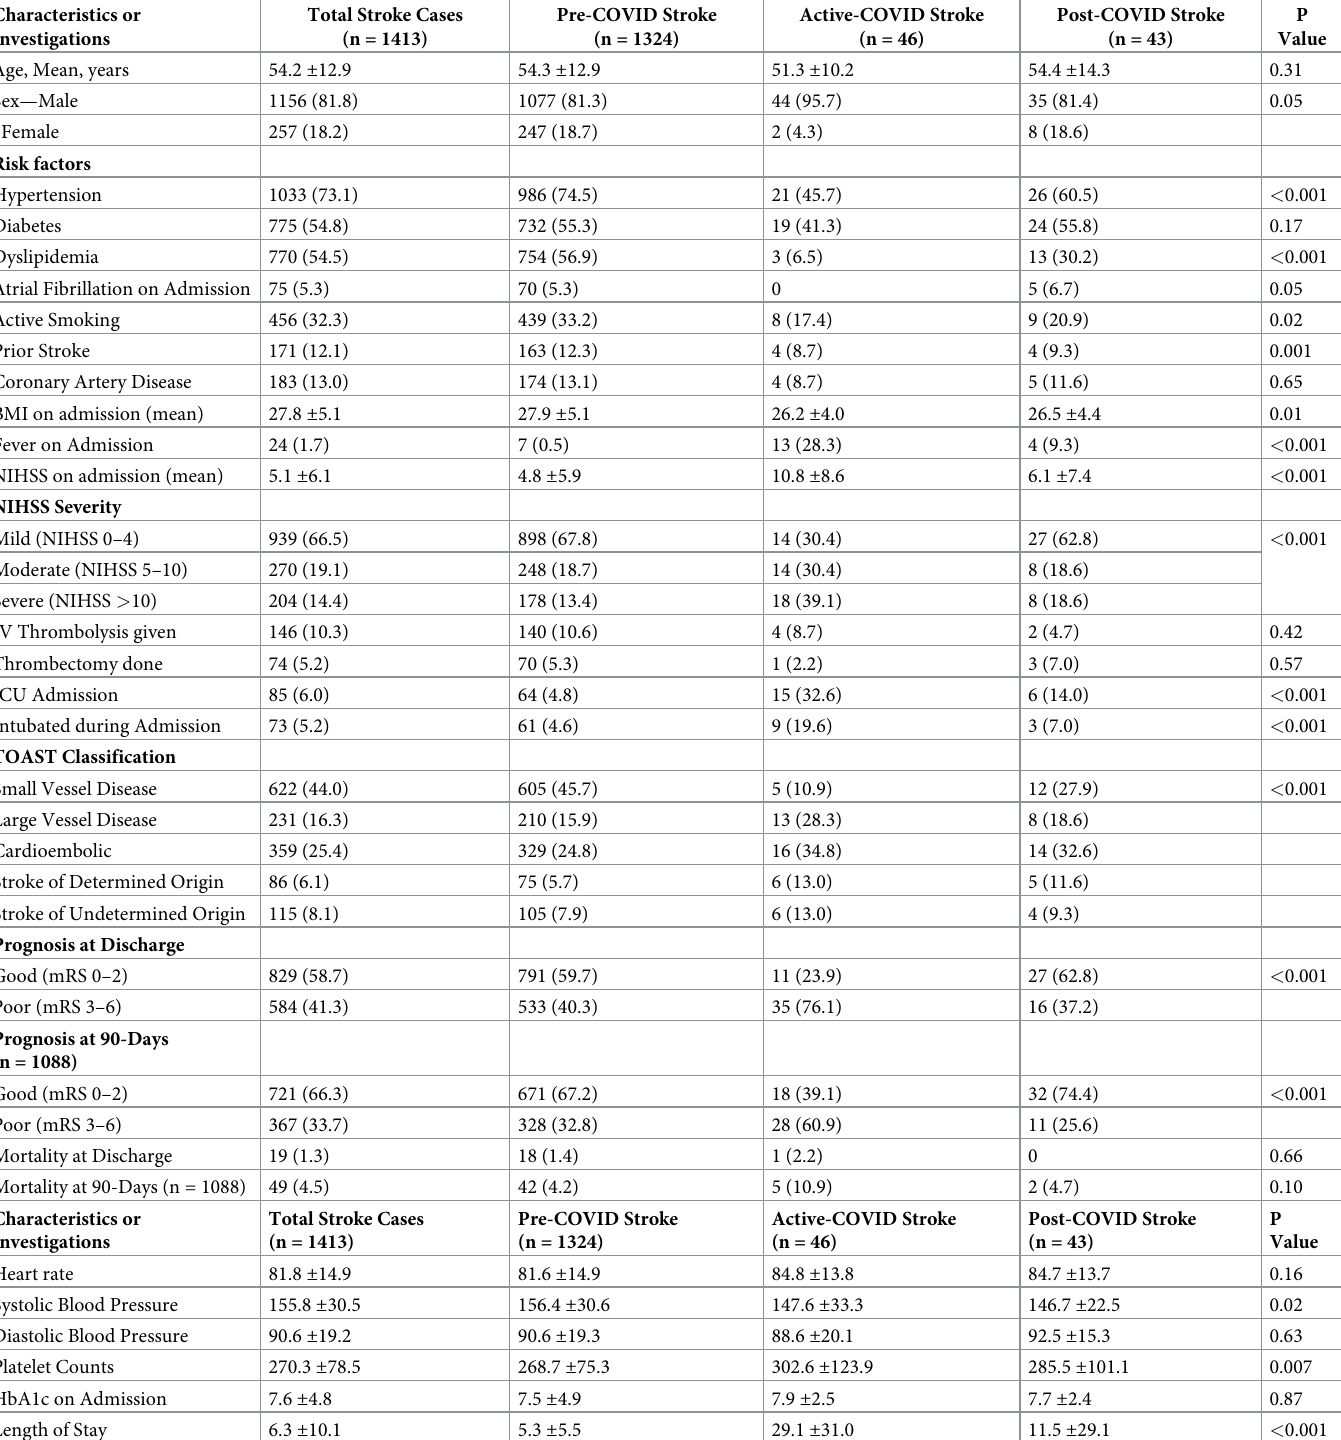
Table 1. Demographic and clinical characteristics of patients with recovered COVID-19, active COVID-19, and pre-pandemic stroke patients. Characteristics or